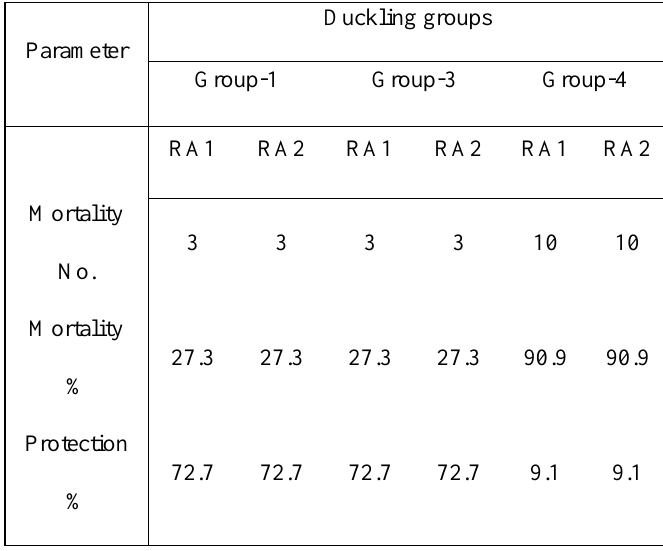
Table 3: Riemerella challenge